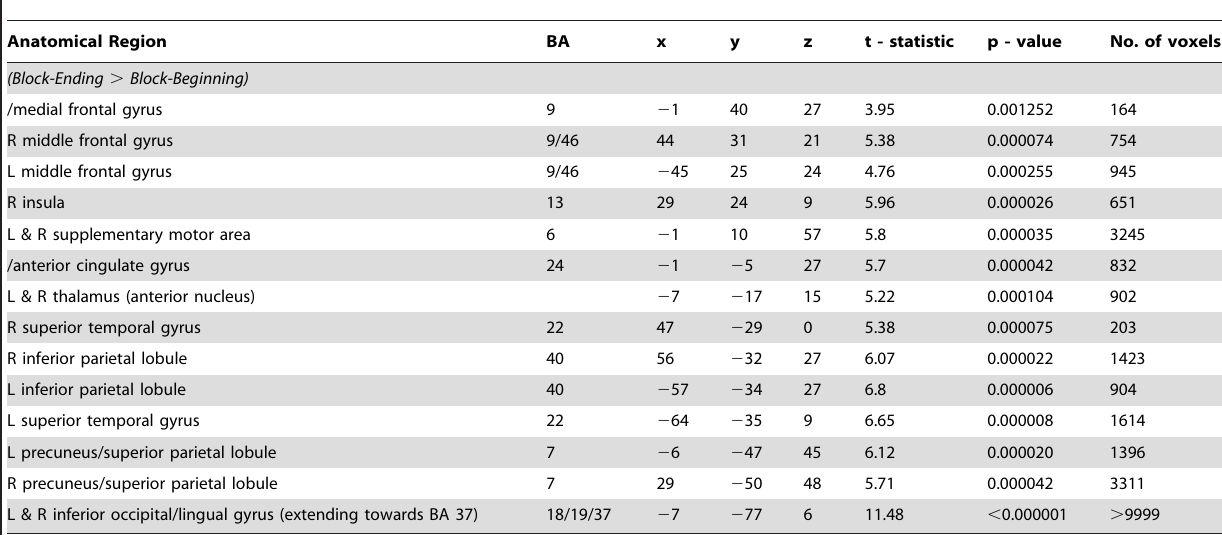
All x, y, and z values represent stereotaxic coordinates according to the coordinate system by Talairach and Tournoux (1988). The statistical values in the next columns correspond to the t -statistics and the p -values of the activation maxima (peak voxel) within each anatomical region. All activations were thresholded at q(FDR) , 0.05 (t=3.71). (BA=Brodmann area; R=right hemisphere; L=left hemisphere) .